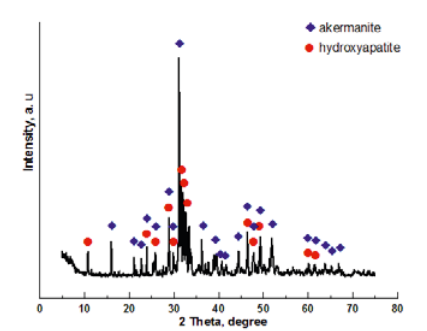
Figure 1. XRD of Ca-1 sample after thermal treatment at 1200 o C/2 h